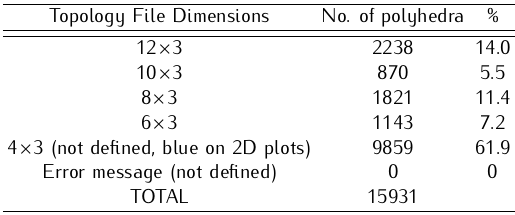
Figure 1. Global distribution of soft sediments in CRUST 2.0 database (purple color).